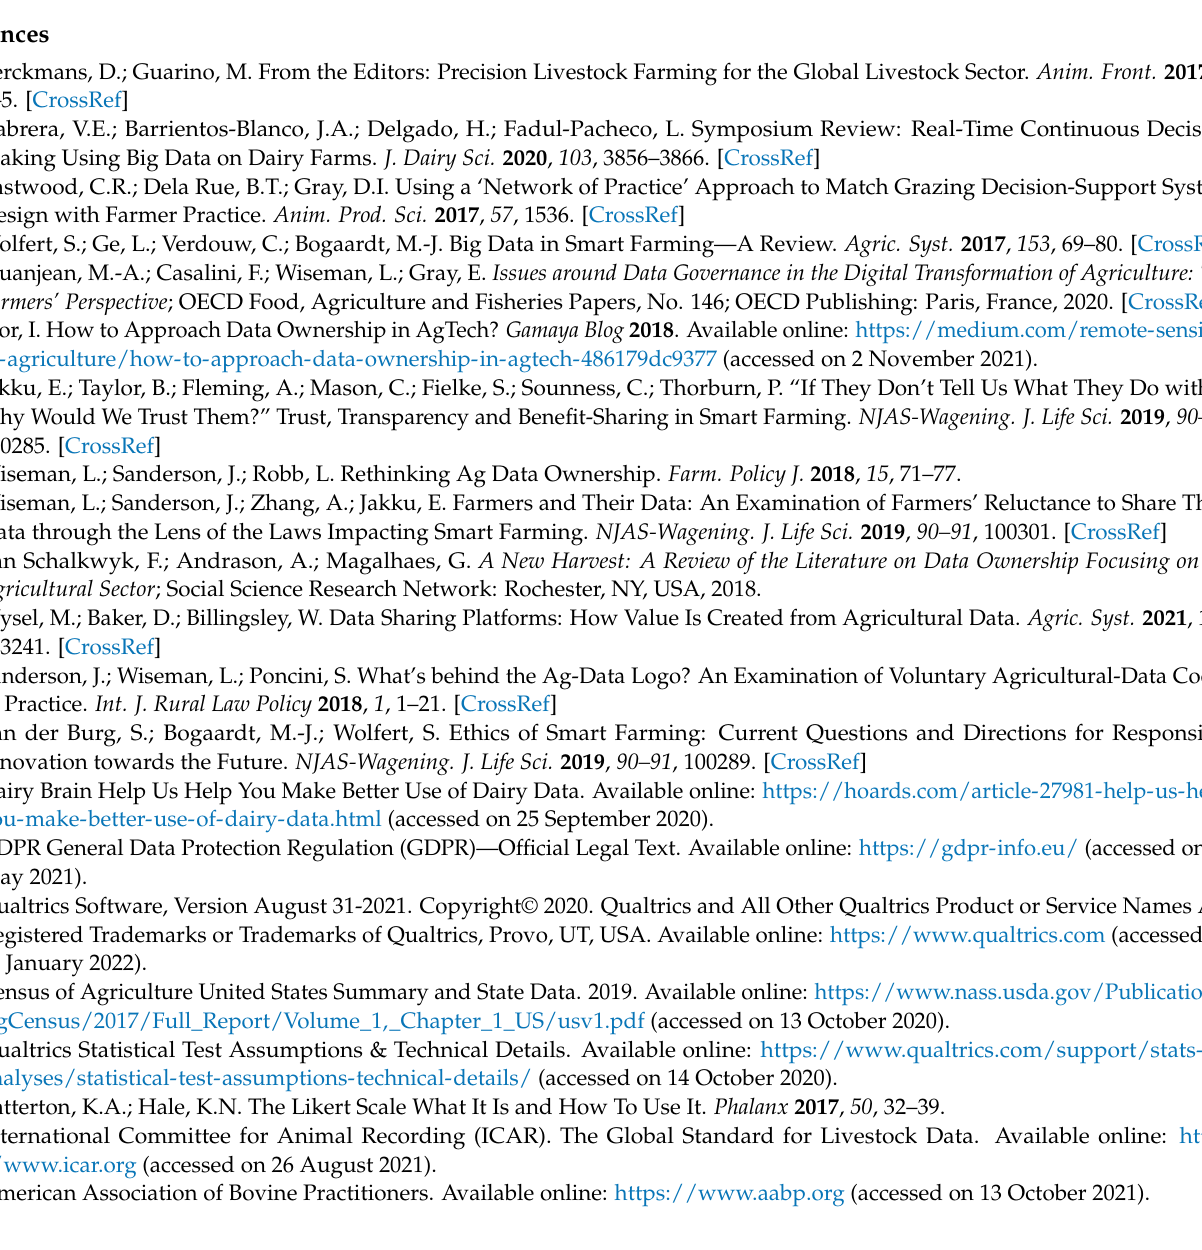
Figure A2. Herd size of the farmers respondents.